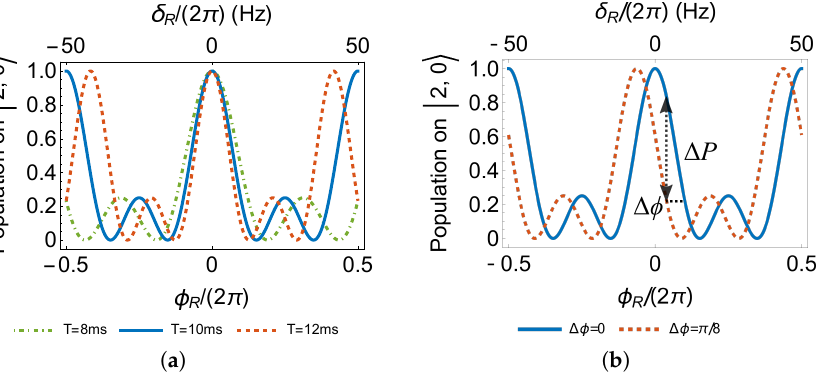
Figure 6. ( a ) Determination of fringe center with different evolution time T . ( b ) Demonstration of fringe slope linearity to interferometer phase shift.